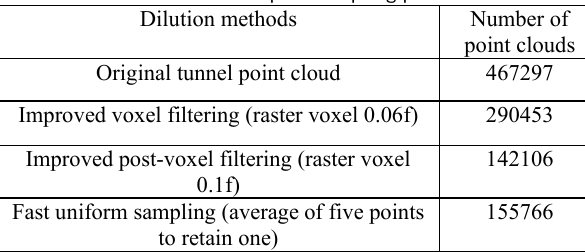
Table 2 . Number of post-sampling point clouds